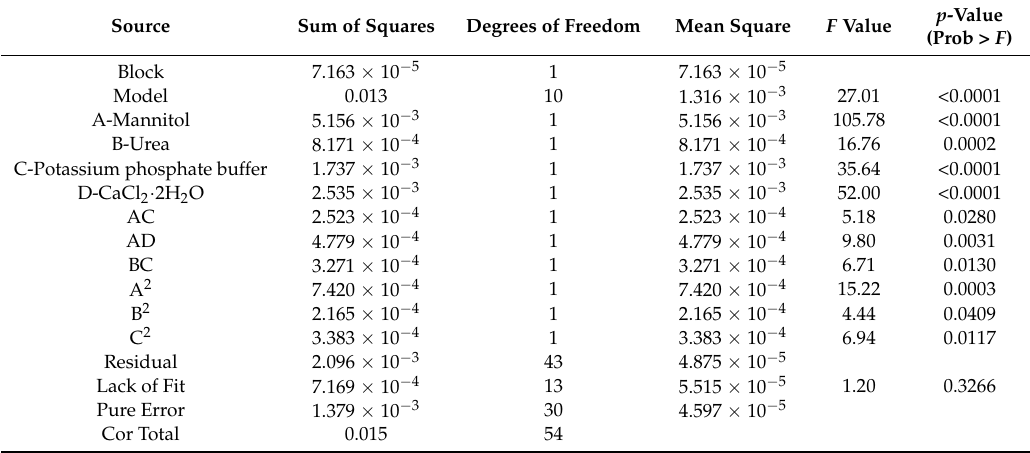
Table 8. ANOVA for the regression model of Y P/S obtained from CCD